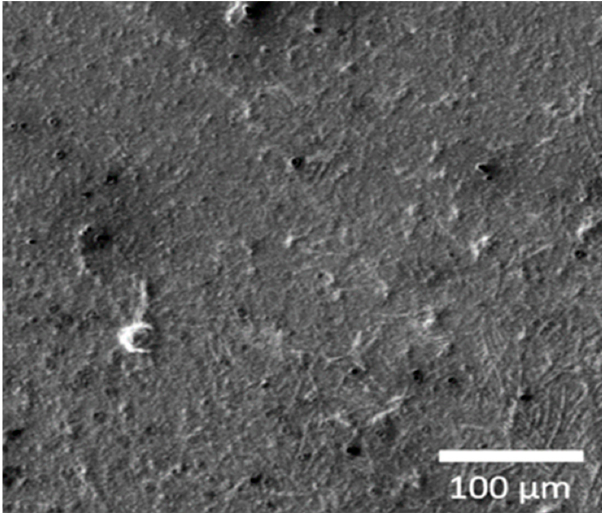
Figure 3. Ma AgNPs transmission electron microscopy (TEM) micrograph taken at 80 kV ( A ) and frequency histogram ( B ).